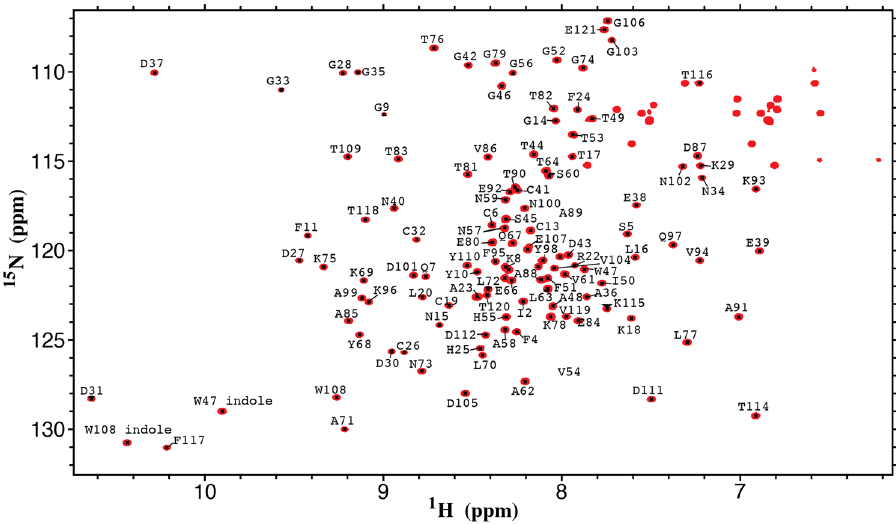
Figure 4. Full 1 HN 15 N HSQC spectrum of RXFP2 (1–65) P4F with residue assignments. Unmarked resonances in the upper right corner belong to Asn and Gln sidechains and have not been assigned. Residues I2 to E66 correspond to the LDLa-linker while residues Q67 to E121 belong to the GB1 module.